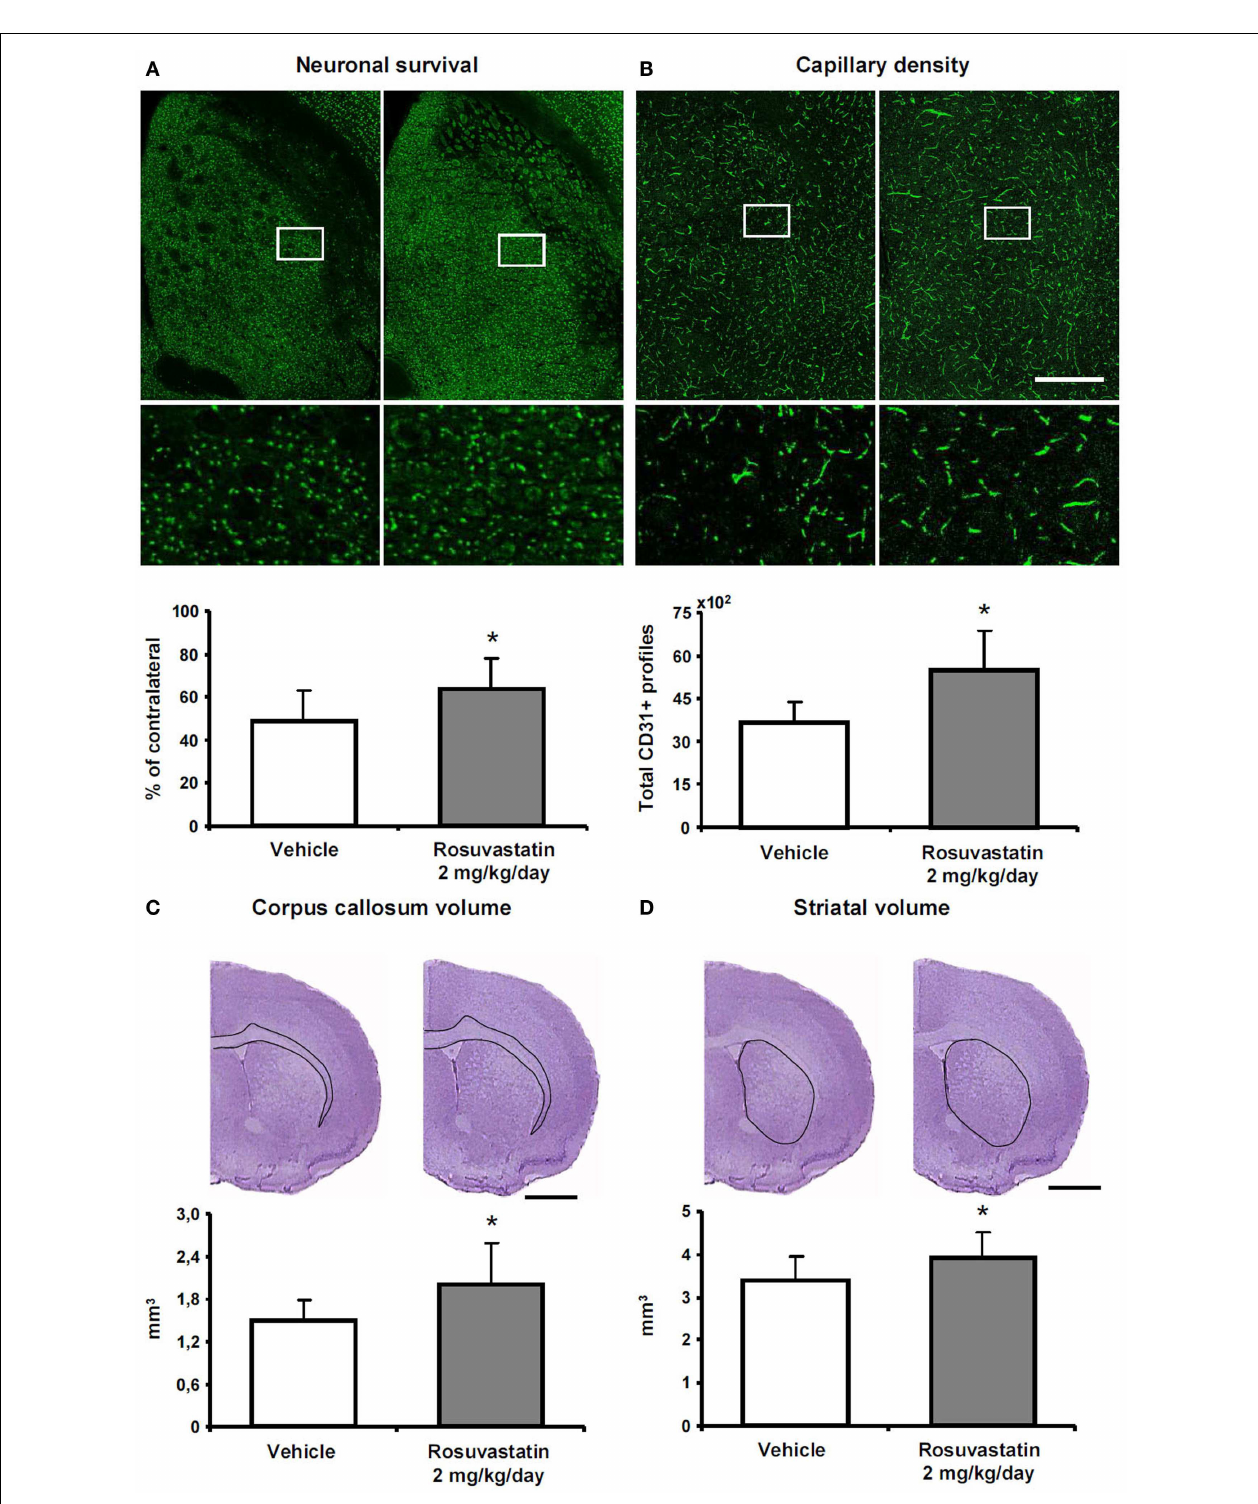
post-ischemia. Data were analyzed using an investigator-independent computer-based stereology and volumetry approach. Note that rosuvastatin increases neuronal survival (A) , diminishes progressive brain atrophy (B,C) , and increases capillary survival (D) . Representative microphotographs are also shown. Data are mean values ± SD ( n = 10 animals/group). * p < 0.05 compared with ischemic vehicle. Bars, 1000 µ m (A–D)